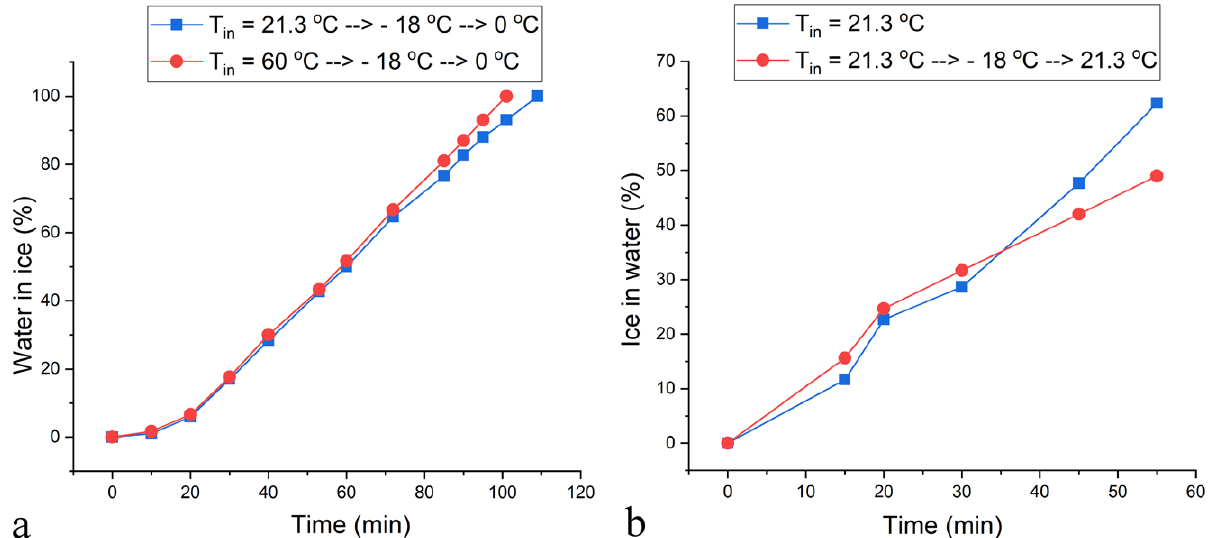
Figure 7. Percentage of the total volume of water in the 30 ml ice samples as a function of the time of incubation at room temperature for DI ice formed from water with different starting temperatures, including 25 and 60 o C (a). Percentage of the total volume of ice in the 30 ml water samples as a function of the time of incubation at -18 o C for the DI water with the starting temperature of 25 °C and the freshly thawed DI water at the same starting temperature (b).